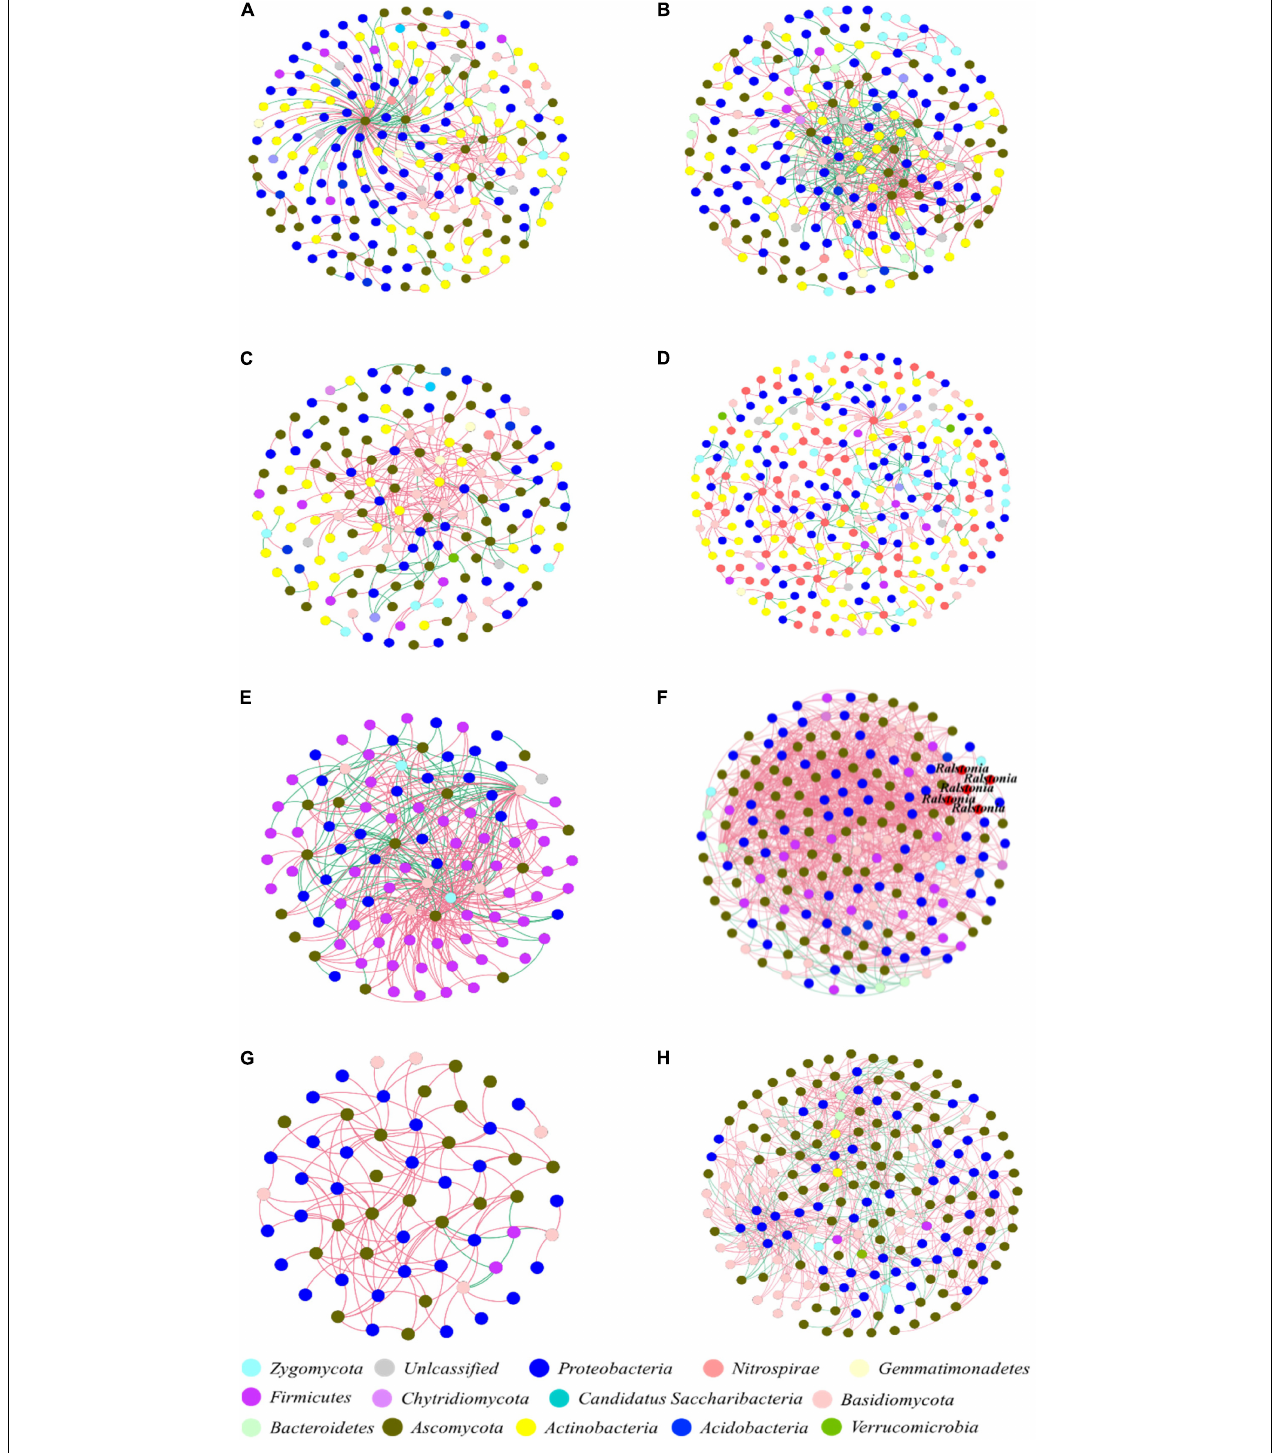
FIGURE 4 | Interdomain ecological networks of the bacterial-fungal associations of healthy and infected samples. (A) Healthy bulk soil. (B) Infected bulk soil. (C) Healthy rhizosphere soil. (D) Infected rhizosphere soil. (E) Healthy root endophytic compartment. (F) Infected root endophytic compartment. (G) Healthy stem endophytic compartment. (H) Infected stem endophytic compartment. Node color indicates phylum-level taxonomy, and the pathogen Ralstonia was labeled at the genus level. Blue links indicate positive correlations between nodes, and red links indicate negative correlations.